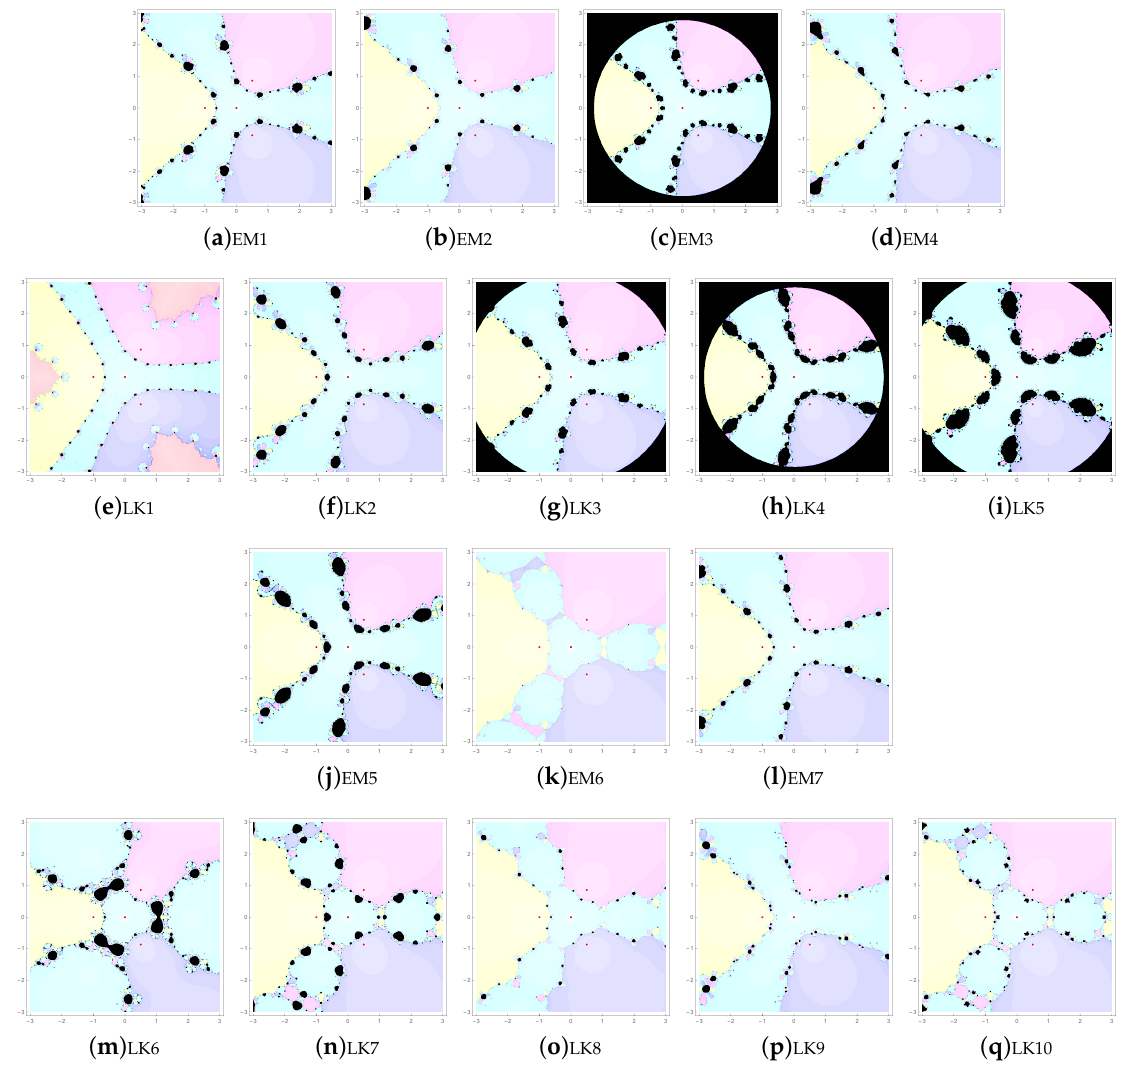
Figure 3. Basins of attraction of the listed methods, for the roots of the polynomial z ( z 3 + 1 )